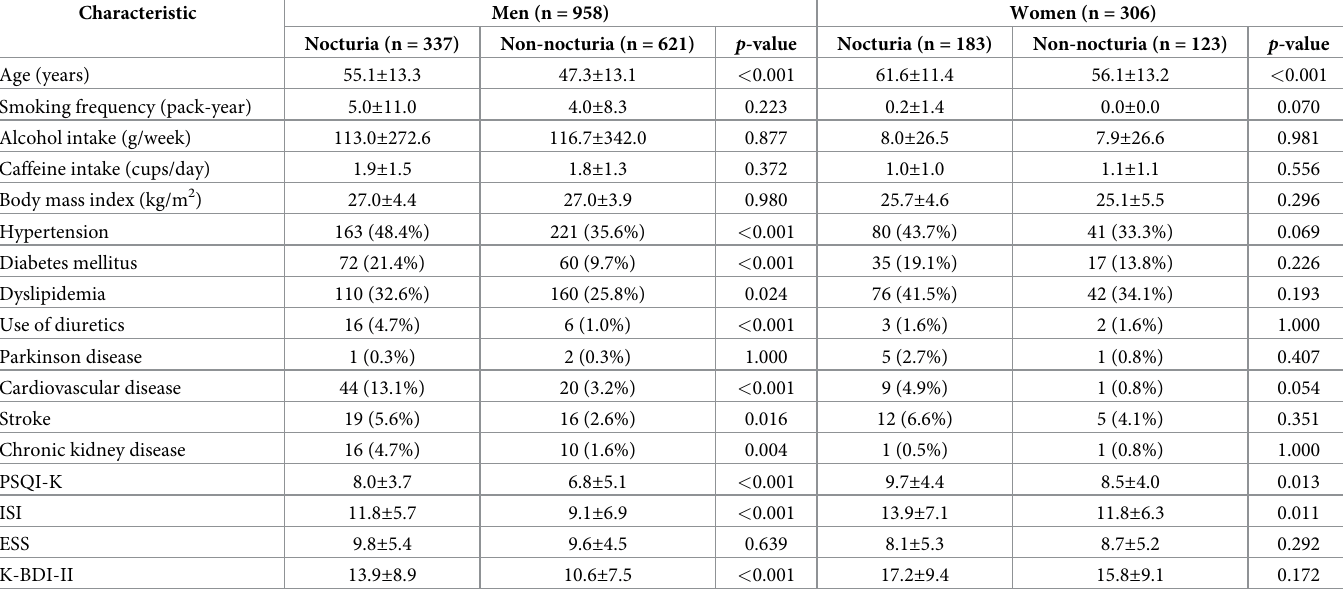
Table 1. Participants’ characteristics by group and sex (N =